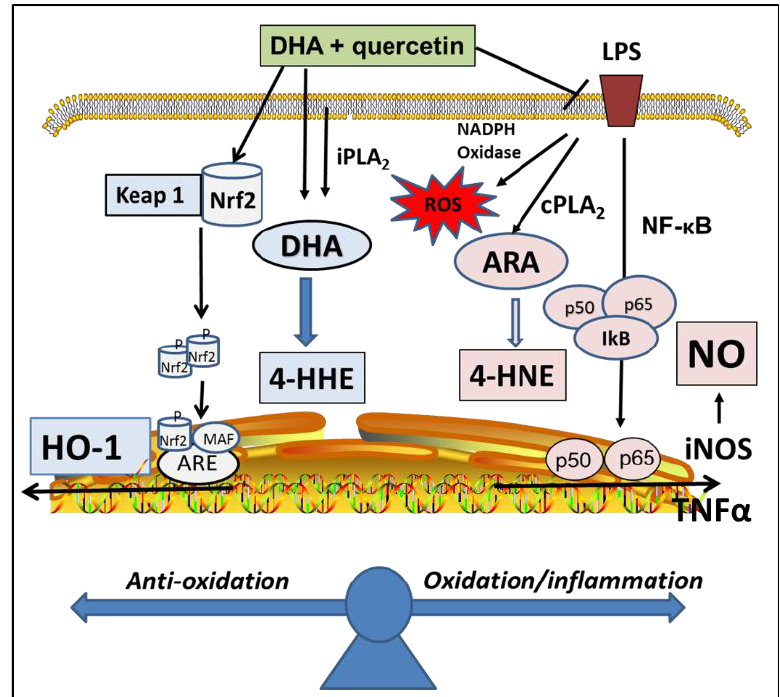
Figure 7. An integrated scheme depicting effects of DHA and quercetin on up-regulation of the Nrf2/HO-1 pathway and down-regulation of NF-κB/TNFα/cPLA 2 /ROS pathways, and metabolic pathways for production of 4-HHE and 4-HNE through lipid peroxidation mechanisms.